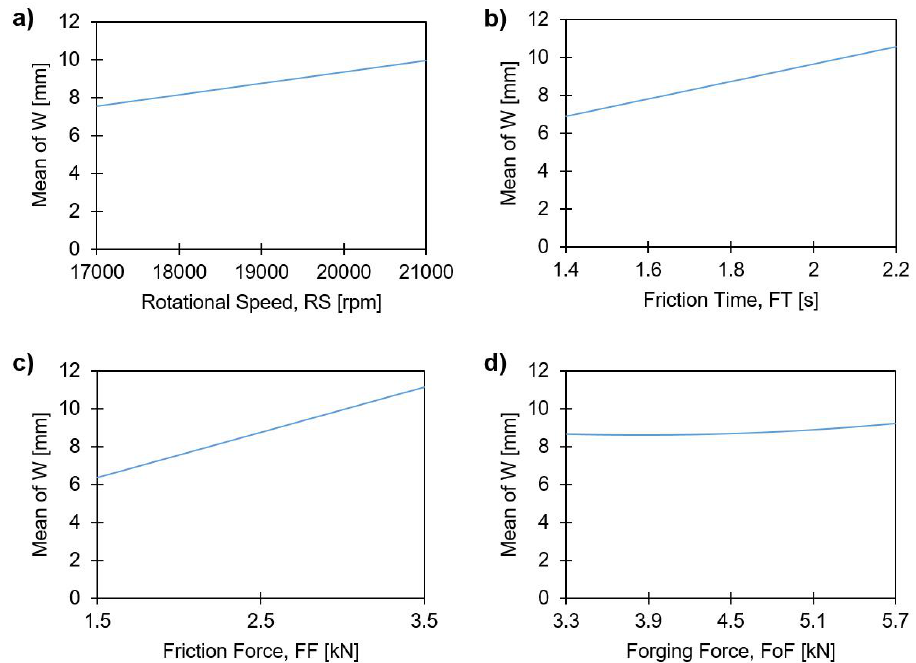
Figure 15. Main effects plots of the maximum width of the deformed rivet, W, with: ( a ) rotational speed; ( b ) friction time; ( c ) friction force; and ( d ) forging force.